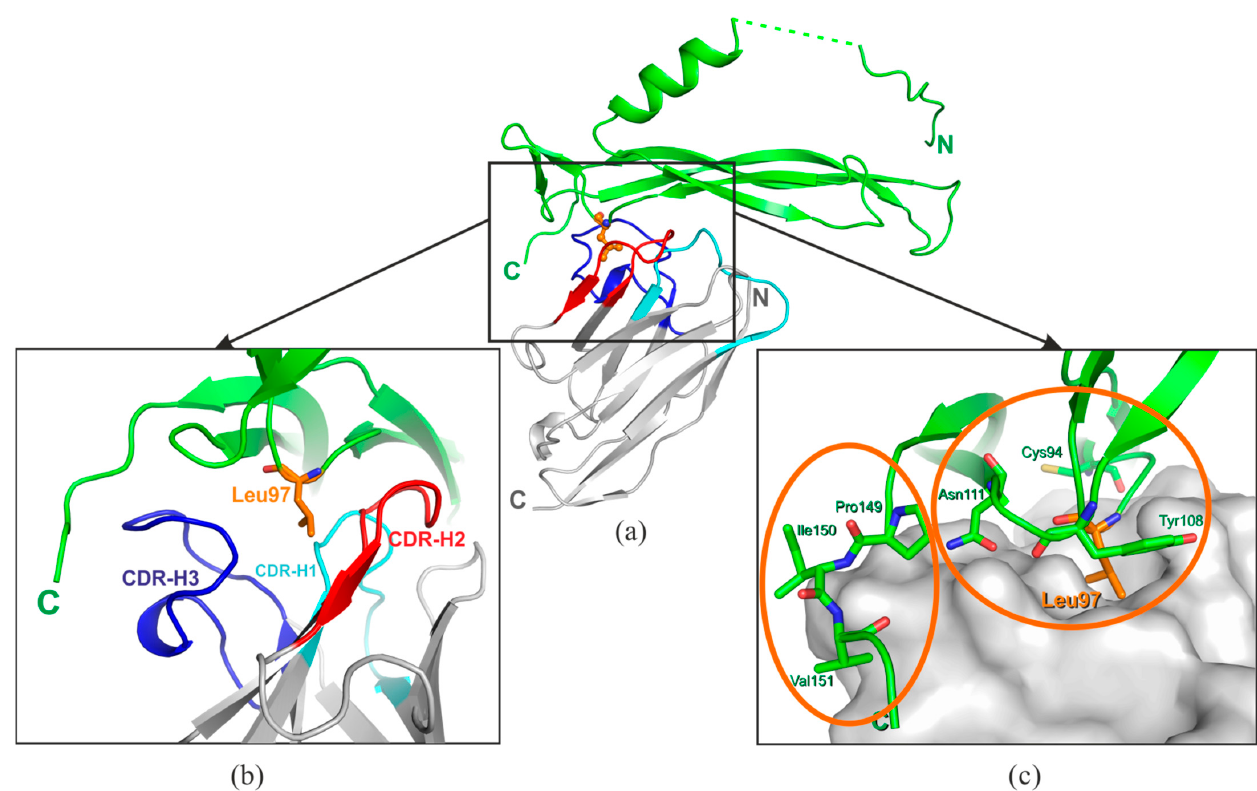
Figure 7. Detailed analysis of the epitope-paratope site in the IL-17A/anti-IL-17A-76 complex. IL-17A—green, anti-IL-17A-76—grey. CDR-H1—blue, CDR-H2—red, CDR-H3—dark blue. ( a ) A general view of the IL-17A monomer/anti-IL-17A-76 structure. ( b ) A general view of the complex interface (ribbon model). ( c ) Amino acid residues of IL-17A involved in the interaction with anti-IL-17A-76. Ellipses enclose two areas of the epitope.